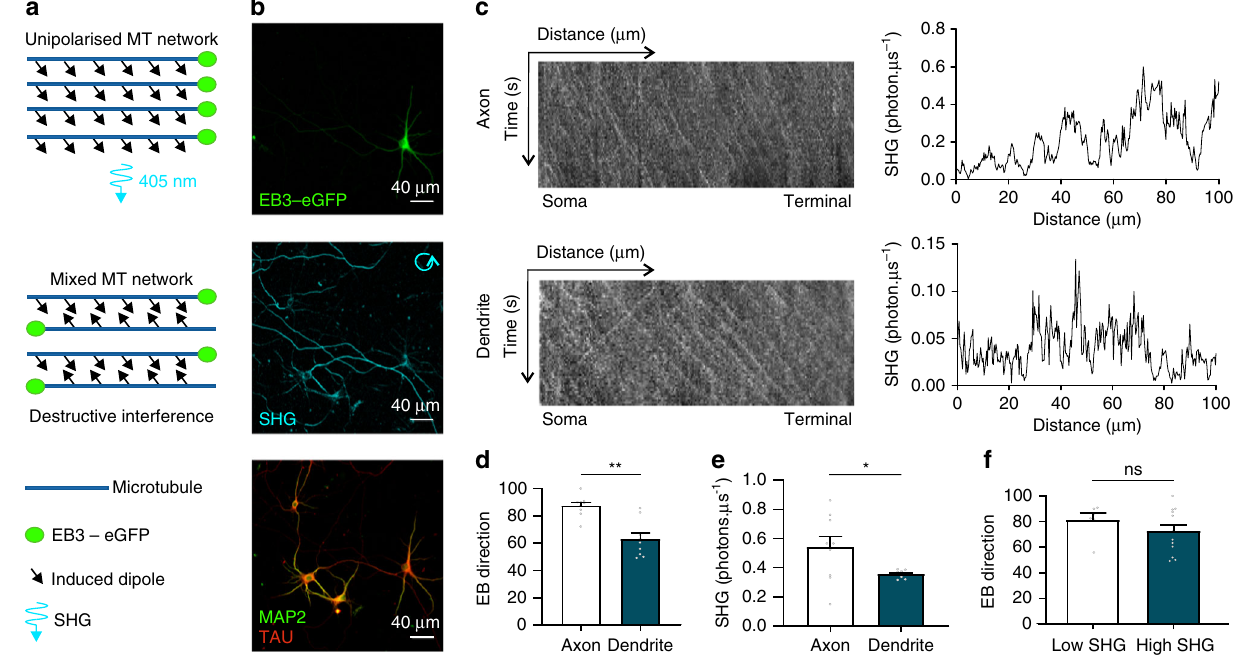
Fig. 2 Uniform microtubule polarity is not suf fi cient to generate SH. a SH signals from a unipolarised microtubule (MT) network lead to constructive interference and increased SH signal intensities while mixed microtubule polarity results in destructive interference and loss of the signal. EB3 proteins bind to the plus ends of a growing microtubule. b First frame of a time-lapse recording of a neuron transfected with EB3-eGFP to determine microtubule orientation, followed by a SHG recording and immunostaining for MAP2 and TAU to differentiate dendritic and axonal projections, respectively. c From the kymograph, EB3 directionality and thus microtubule orientation can be determined. Microtubules where EB3 proteins move towards the distal end of the fi ber (anterograde movement in the kymograph) have the microtubules with their plus ends out towards the growth cone while EB3 proteins moving towards the cell soma (retrograde movement in the kymograph) have the microtubules oriented with their minus ends out towards the growth cone. Based on the EB3 directionality, the (dominant) microtubular polarity of a fi ber was determined followed by a recording of the SH signal intensities along that fi ber. A SH intensity plot was generated from the proximal towards the distal end of the neuronal process. d Quanti fi cation of EB3 directionality, with signi fi cantly increased anterograde EB3 comets in axons compared with dendrites ( n = 9 cells from three independent experiments, ** p < 0.01, unpaired two-tailed t -test). e A signi fi cant increase in SH signal intensity was measured in axonal projections ( n = 9 cells from three independent experiments, * p < 0.05, unpaired two-tailed t -test with Welch ’ correction). f No signi fi cant difference was found in the fraction of plus-end out microtubules